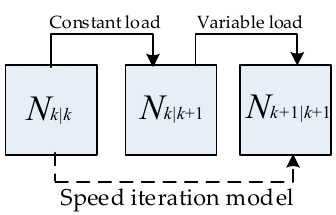
Figure 3. Relationship of speed in the iteration model.